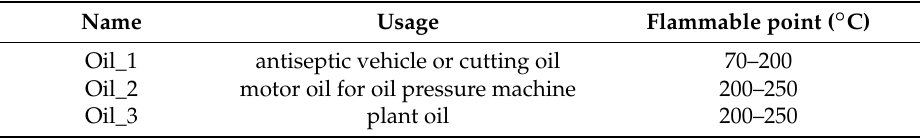
Table 1. Oils used in this